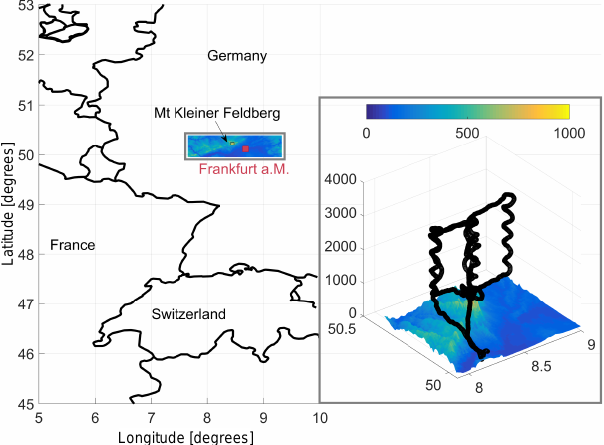
Figure 1. Topographic map (colour bar in m) of the Rhein-Main Area in southwest Germany near Frankfurt am Main including the flight pattern on 6 September 2011 (black line). Vertical profiles are indicated by the flight track spirals. All descending profiles were flown near the summit of Mount Kleiner Feldberg, while ascending profiles have been taken up- and